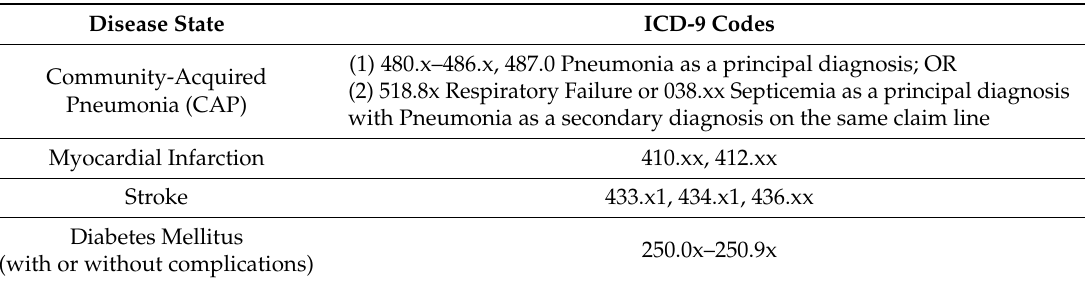
Table A1. Disease state ICD-9